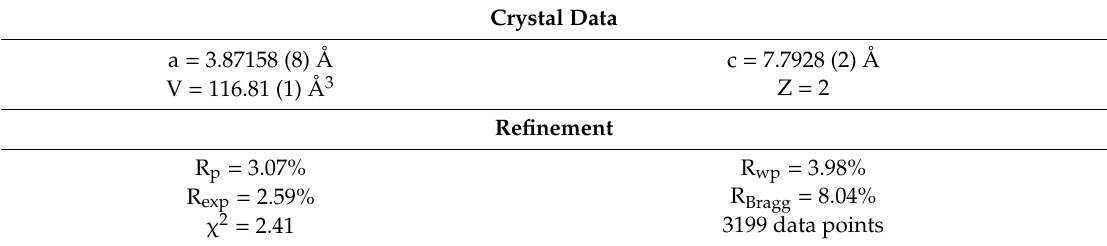
Figure 2. Observed (crosses), calculated (full line) and difference (at the bottom) neutron powder diffraction (NPD) profile for Sr 0.9 Ba 0.1 Co 0.95 Ru 0.05 O 3 −δ phase at 25 ° C, refined in the tetragonal P4/mmm space group. The vertical markers correspond to the allowed Bragg reflections. Table 1. Structural parameters for SrCo 0.95 Ru 0.05 O 3 −δ refined from neutron powder diffraction (NPD) data at 25 ° C.